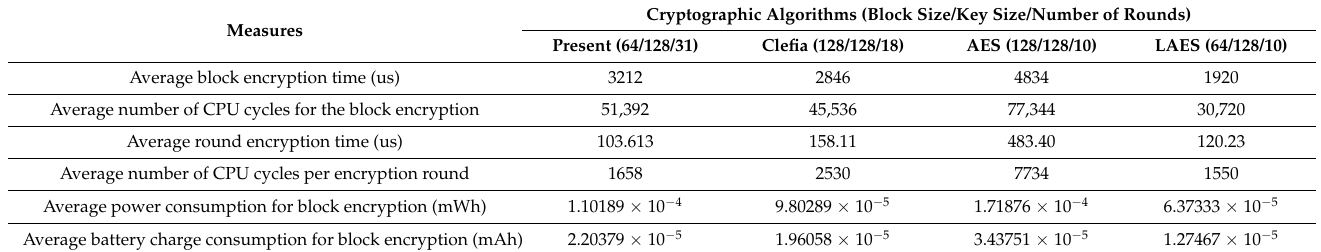
Table 8. Evaluation outcomes based on the 8-bit microcontroller Arduino Uno